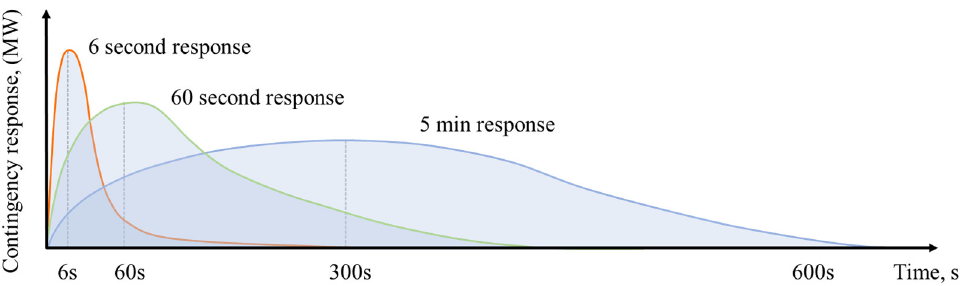
Figure 3. FCAS raise contingency response (conceptual illustration). Adapted from [43].